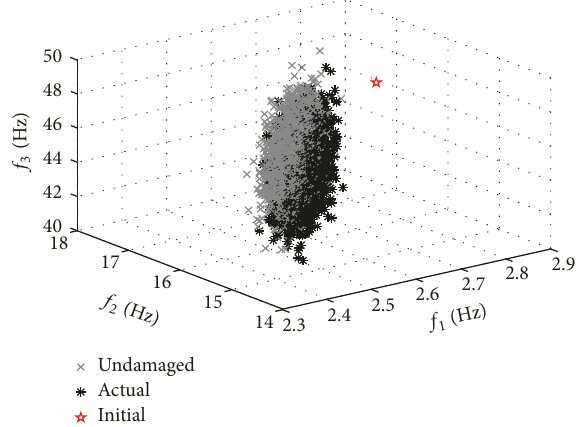
Figure 3: First three actual modal frequencies set (3000 samples) and initial modal frequencies